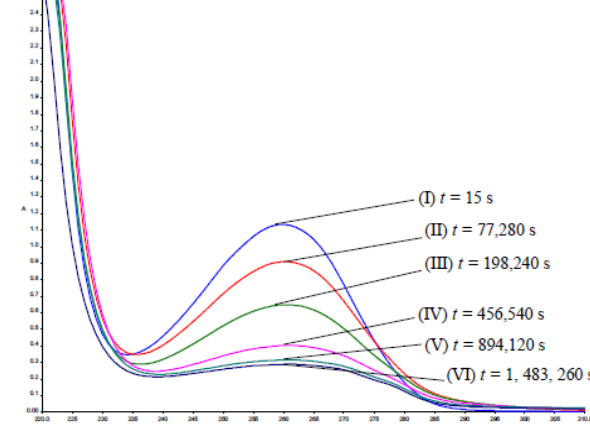
Figure 4 : UV-Vis absorption spectra of alkaline hydrolysis of AMPNa at [NaOH] 1M at 60°C.